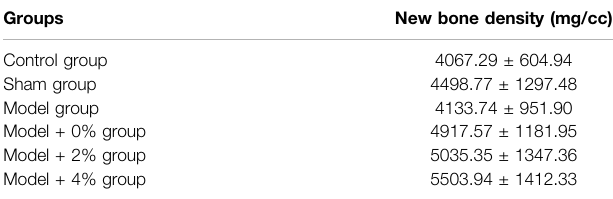
TABLE 2 | New bone density after 12 weeks as analyzed by micro